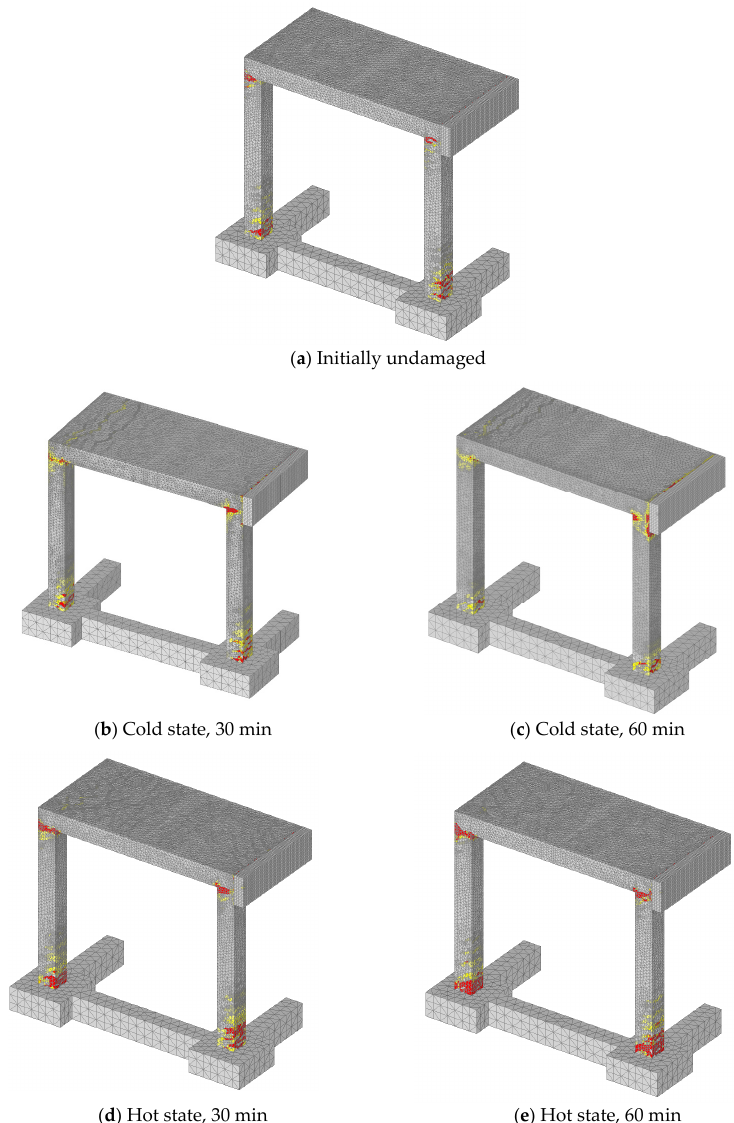
Figure 13. Localization of damage in concrete after peak resistance.